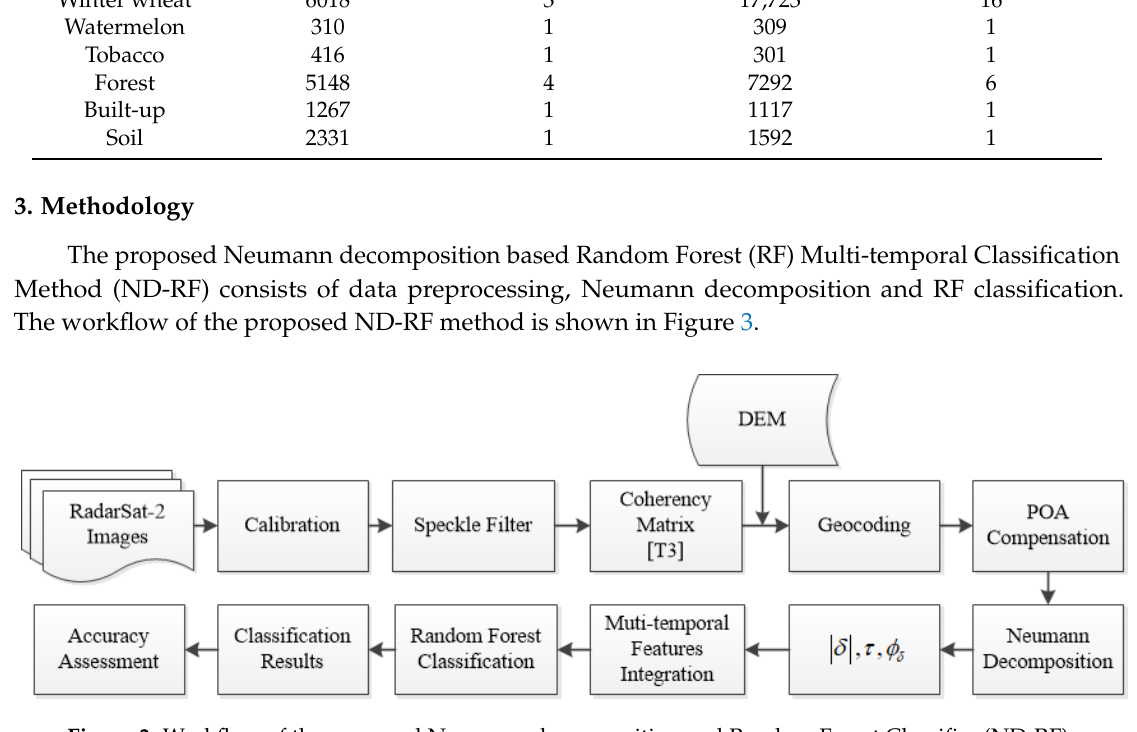
Figure 3. Workflow of the proposed Neumann decomposition and Random Forest Classifier (ND-RF) classification method used in this study.